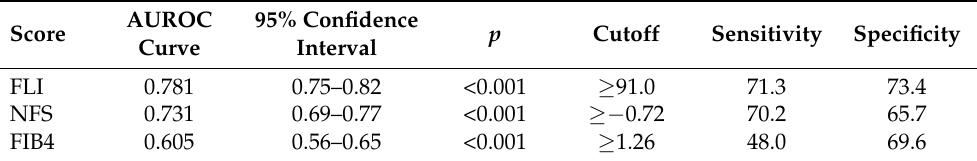
Table 3. Evaluation of AUROC curves and determination of cutoff values, together with sensitiv- ity and specificity, for diagnostic scores regarding significant fibrosis in patients with metabolic dysfunction-associated fatty liver